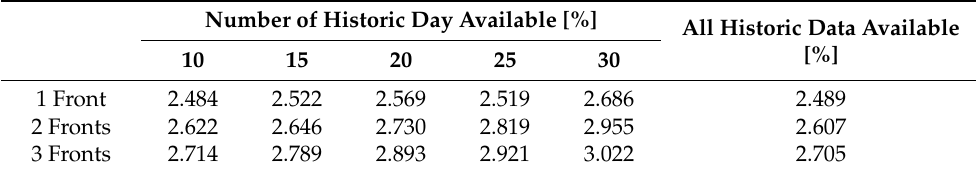
Table 13. MAPE values for Pareto fronts models with and without available historic data limitation. Number of Historic Day Available [%] All Historic Data